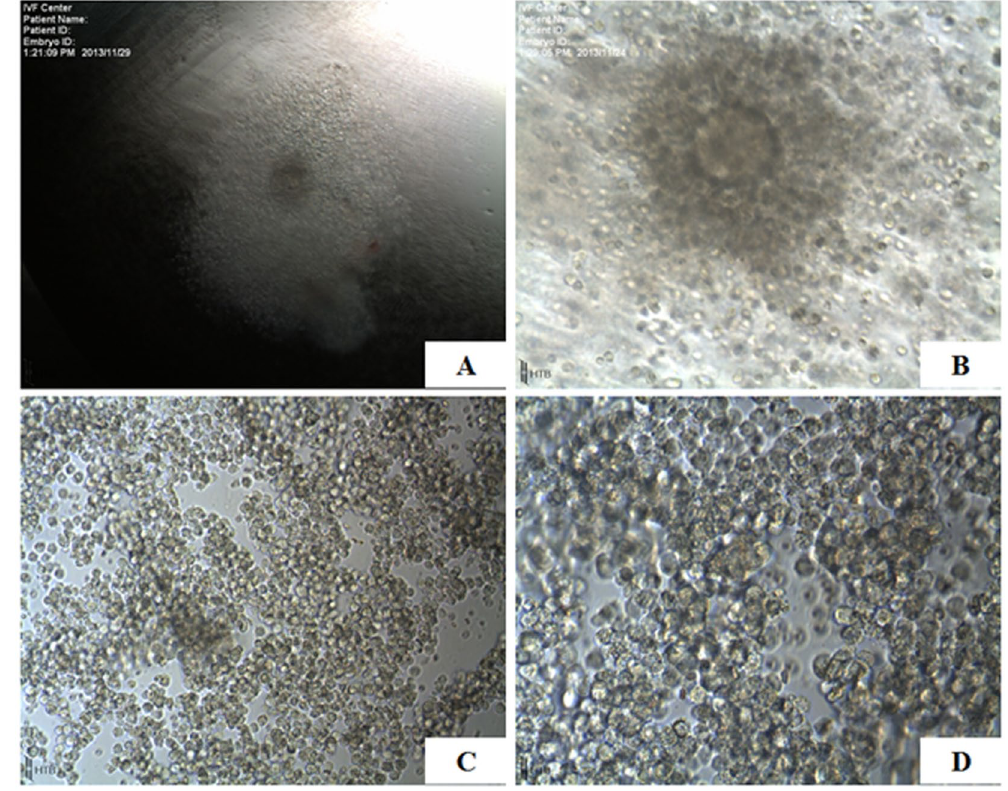
Figure 7. Oocyte corona cumulus complex, (OCCCs) ( A and B ) and cumulus granulosa cells ( C and D ). A, × 4; B, × 10; C, × 10; D, ×